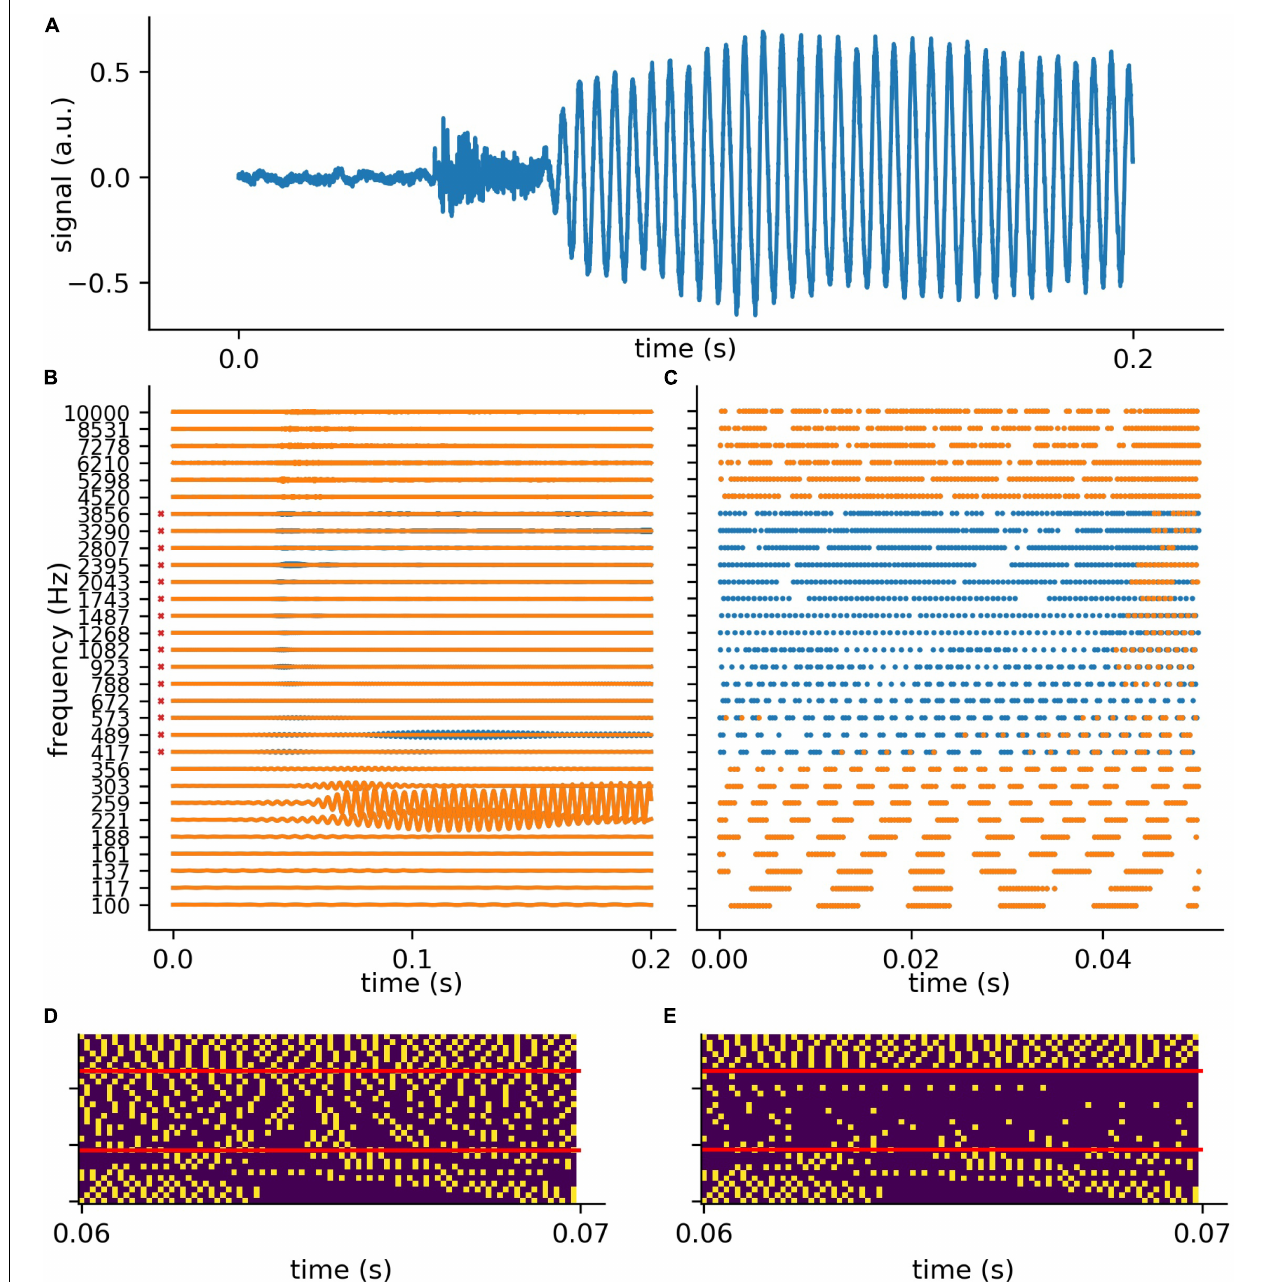
FIGURE 4 | Exemplary processing of a word in cochlea and DCN model. (A) The first 0.2 s of audio data of the German word “die” (the). (B) The 30 frequency components (blue without hearing loss, orange with hearing loss) after the first part of the model, which represents the cochlea and the spiral-ganglion ( Figure 1A ). A virtual hearing loss is applied by weakening the signal at a certain frequency range (e.g., 400 Hz–4 kHz, − 30 dB). The bandpass filtered signal (matrix of 30 frequency channels and f s × signal duration) is fed to the LIF neurons (refractory time: ≈ 0.25 ms ) and spike trains (C) are generated. These spike trains are down-sampled by a factor of 5 and fed to the deep neural network (D) . (E) The same signal (of panel D ) with added hearing loss of 30 dB in the frequency range 400 Hz–4 kHz being the speech relevant